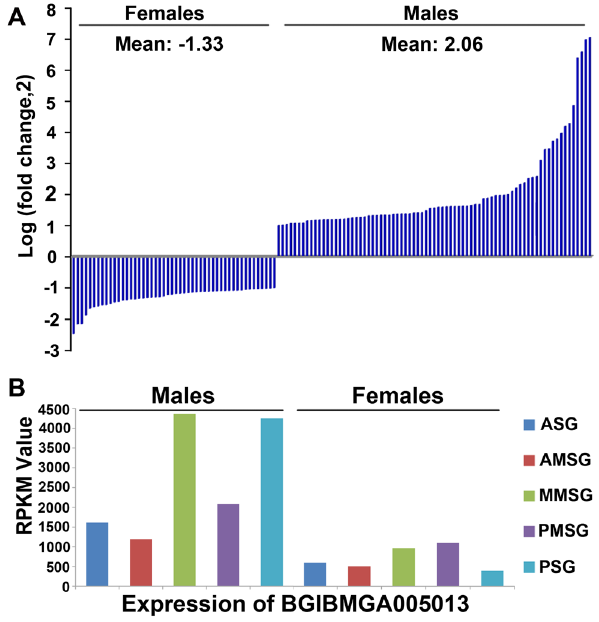
Fig 6. Expression patterns of up-regulated genes in males and females. (A) PSG as an example of the gene expression pattern based on the fold-change between males and females. There are more up-regulated genes in the PSG of males than of females. (B) Expression pattern of the gene